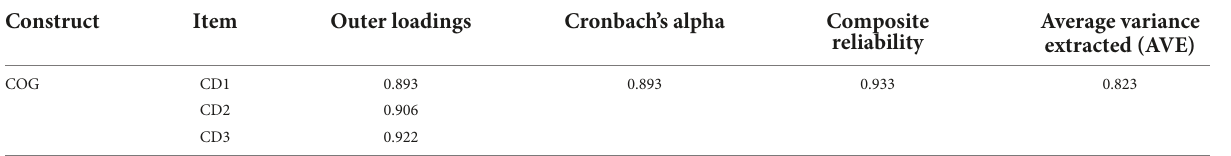
TABLE 7 Reliability and validity for the third-order